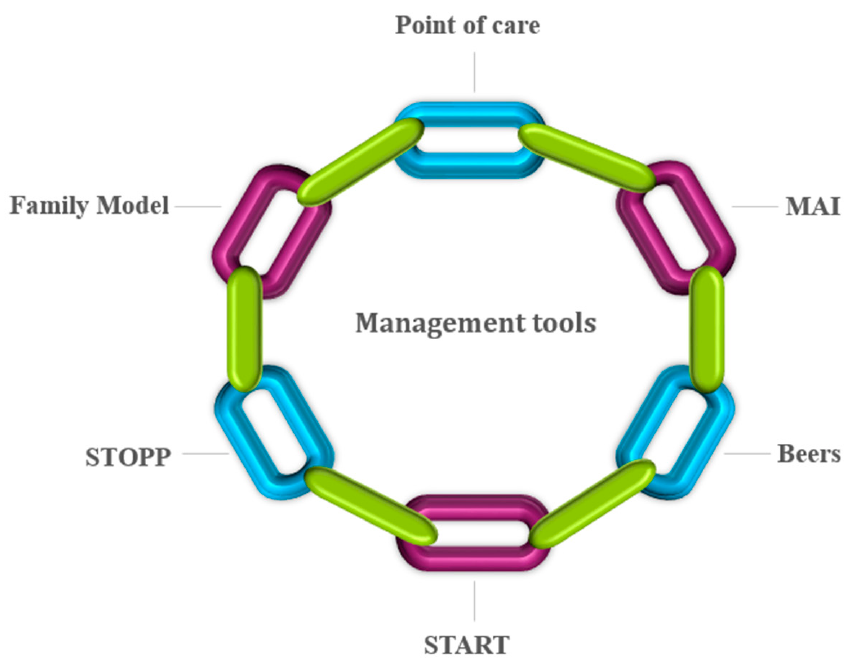
Figure 1. Assessment tools for tracing potentially inappropriate medications.